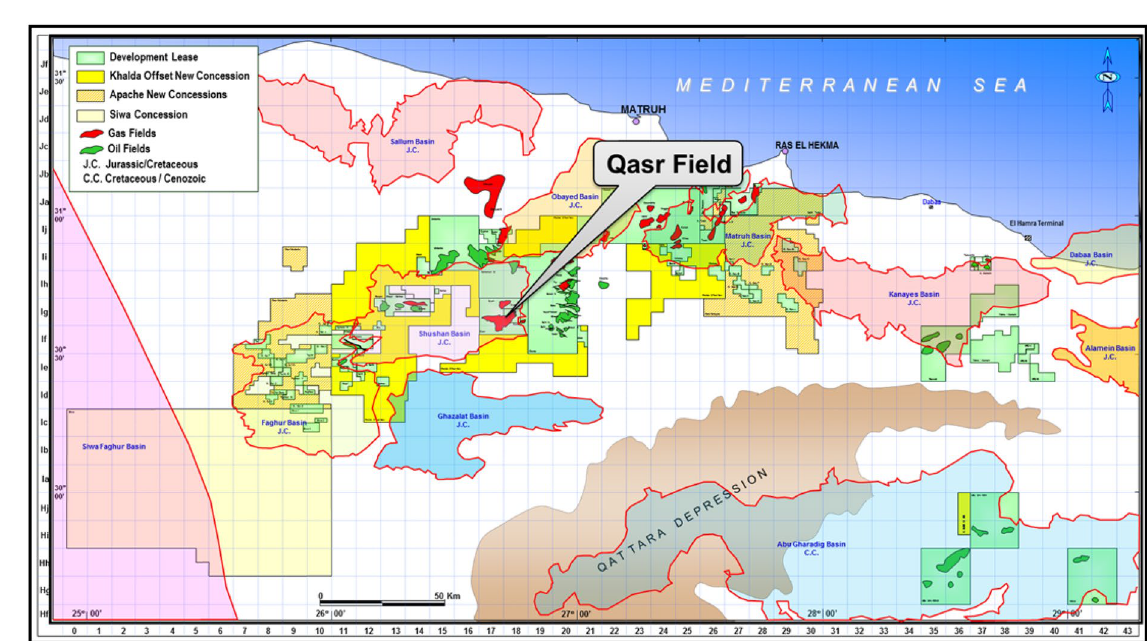
Fig. 1 Northwestern desert concession map showing the location of Qasr